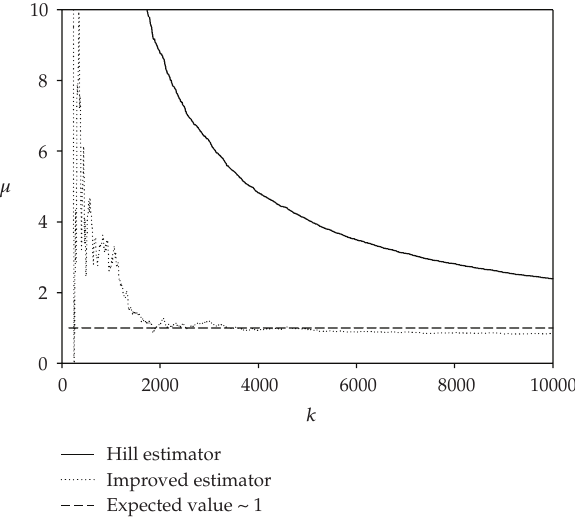
Figure 3: A ln (cid:5) x (cid:6) /x behavior (cid:5) see Example 16 (cid:6)